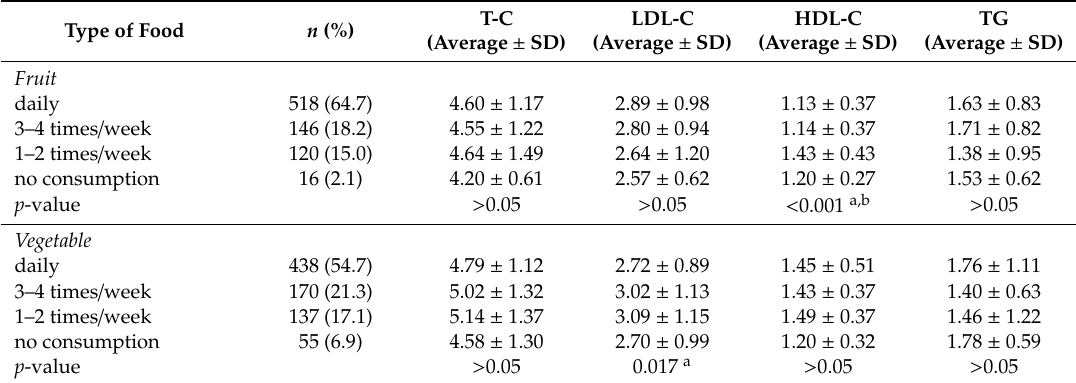
Table 8. E ff ect of the frequency of consumption of fruit and vegetables on lipid profile.